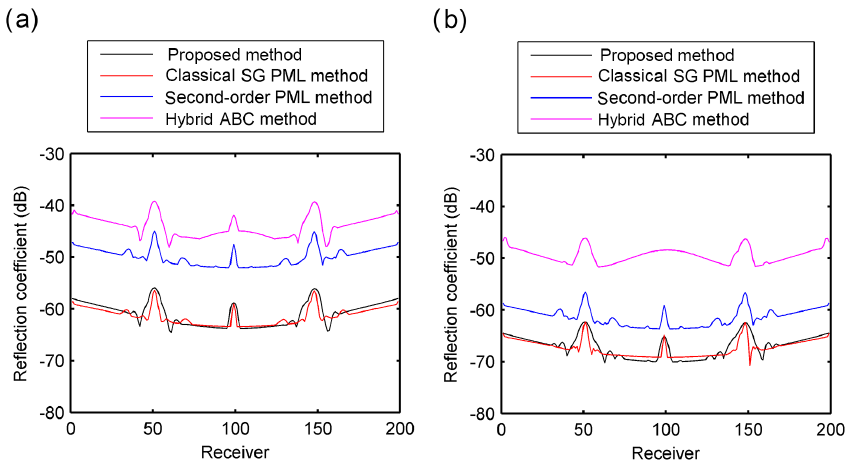
Figure 13. Values of the absorption coefficient R at each receiver for our method (red line), the classic SG PML method (black line), the second-order PML method (blue line), and the hybrid ABC method (magenta line): (a) 10 absorbing layers and (b) 20 absorbing layers.